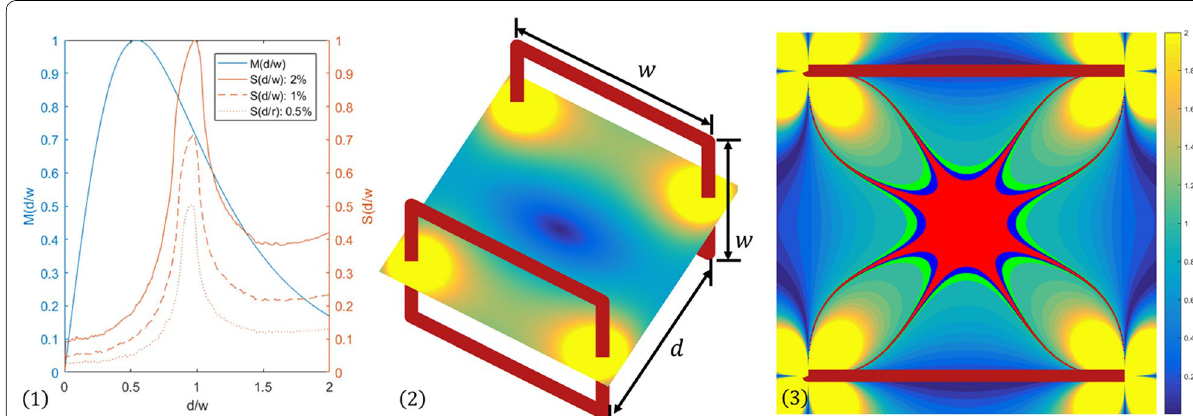
Figure 11 Optimization result for the squared-shaped coil pair inducing uniform gradient field